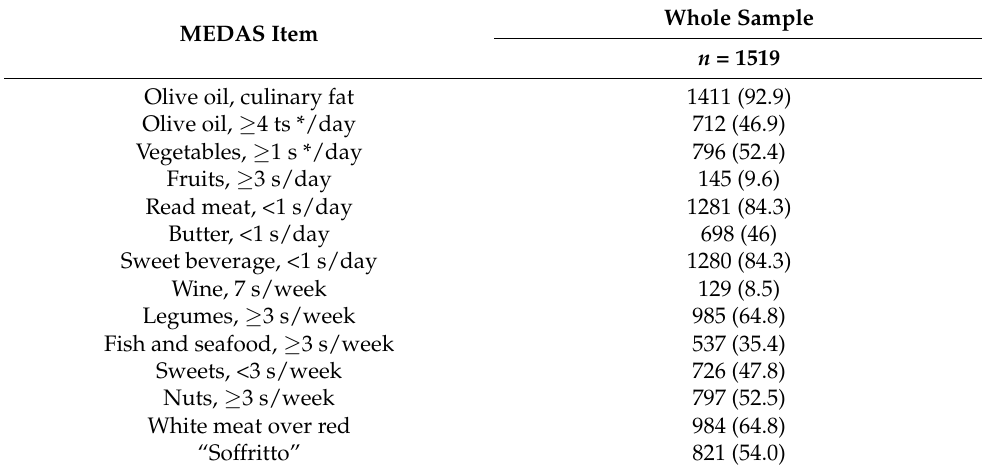
Table 2. Positive answer to MEDAS